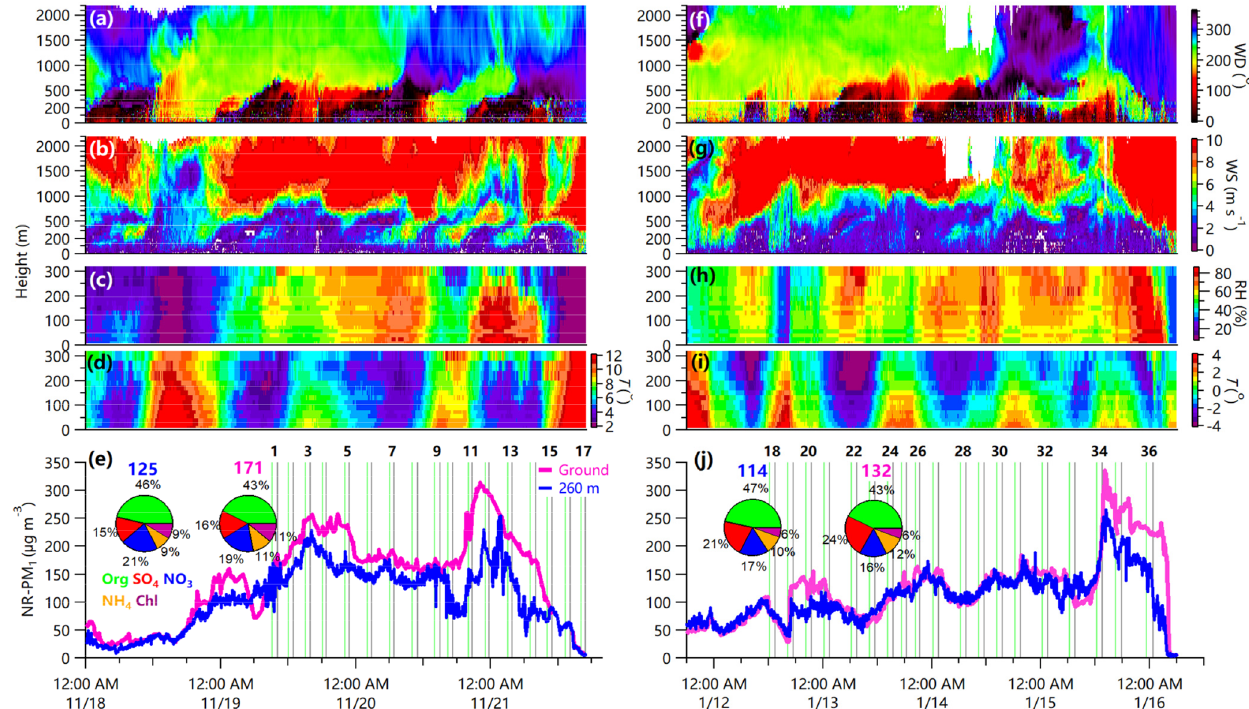
Figure 1. Vertical evolution of (a, f) wind direction, (b, g) wind speed, (c, h) relative humidity, and (d, i) temperature during two severe haze episodes in November 2014 and January 2015. Panels (e) and (j) show the time series of NR-PM 1 mass concentrations at ground level and 260m. The two pie charts in each panel present the average composition of NR-PM 1 for each episode at ground level (right) and 260m (left), respectively, and the numbers on the top of pie charts are the average mass concentrations. The number of vertical profile experiments is also marked in panels (e, j) as green (up) and gray (down) vertical lines, and the time for each vertical profile is detailed in Table S1 in the